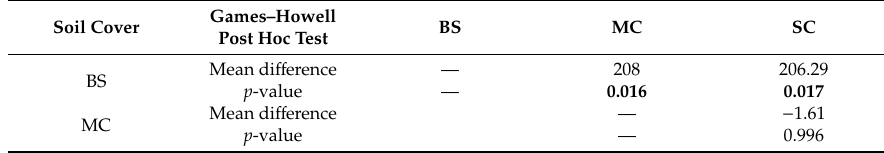
Table 2. E ff ect of soil cover on soil erosion rate (g / m 2 ) based on the Games–Howell post hoc test (BS: bare soil, MC: metal sieve cover, and SC: strip cropping; bold: p < 0.05).